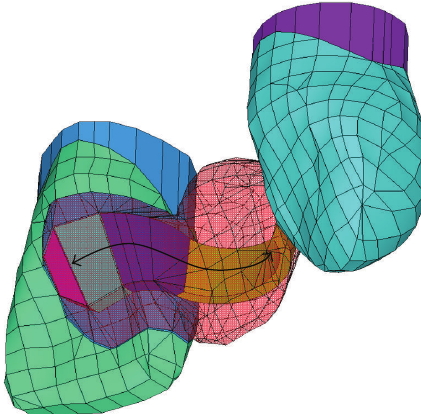
Figure 2: 3D FE model of a two-unit cantilever FRC RBFDP: position of the FRC framework in relation to the FDP and the abutment teeth is shown. Double arrowed black line represents the fibre direction.